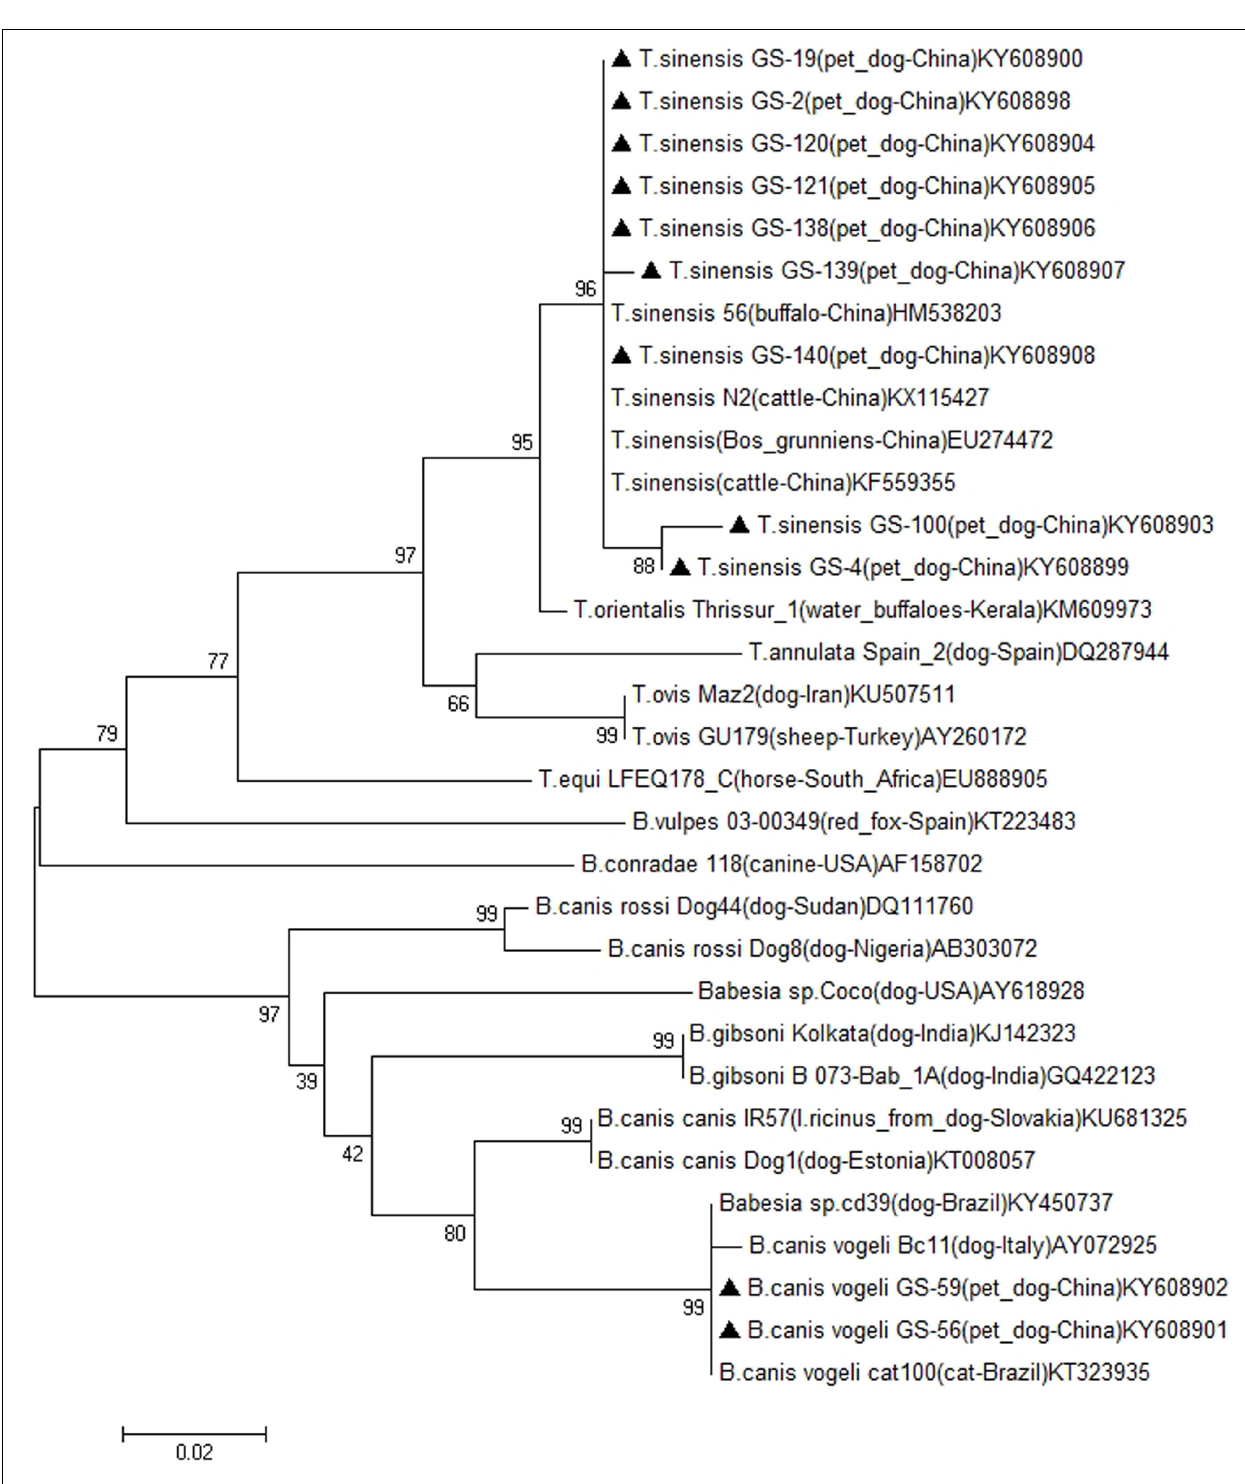
FIGURE 1 | Phylogenetic tree of the nucleotidic sequences of Babesia and Theileria spp. 18S rRNA obtained from pet dogs in this study and deposited in GenBank from different piroplasm species, the isolate, host, countries and accession numbers are shown after species name. The 18S rRNA sequences obtained in this study were indicated with bold triangle. The tree was inferred using the neighbor joining method of MEGA7, bootstrap values are shown at each branch point. Numbers above the branch demonstrate bootstrap support from 1000 replications. All sites of the alignment containing insertions–deletions, missing data were eliminated from the analysis (option “complete